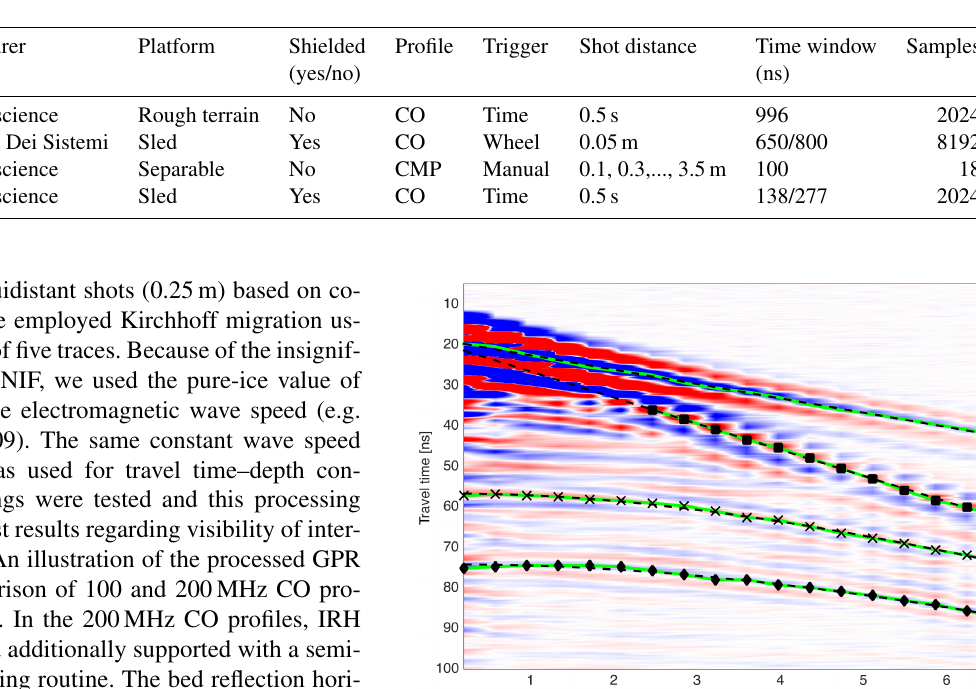
Table 1. Overview of GPR systems used and data acquisition settings. In case of the common-midpoint profile (CMP), number of samples refers to the number of shots to obtain the profile.